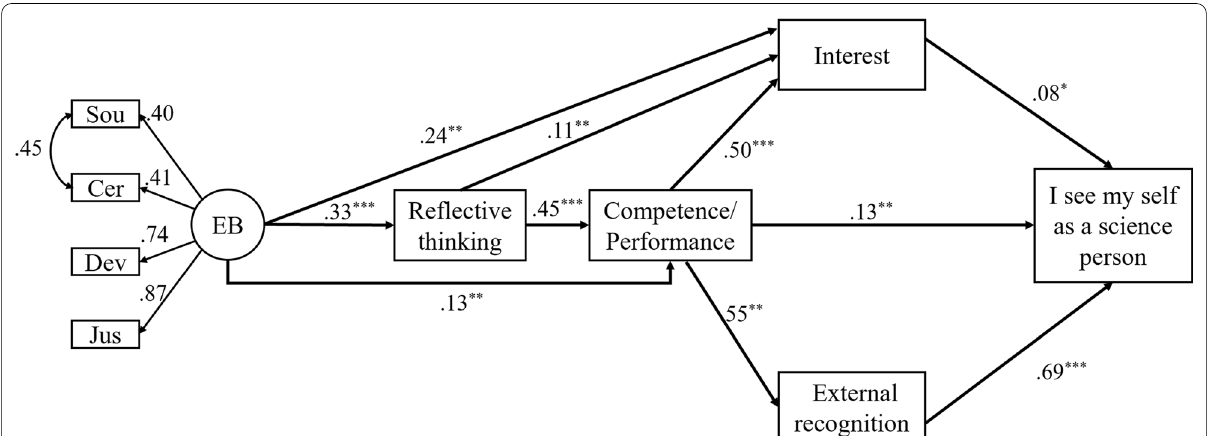
Fig. 4 Direct effects of epistemological beliefs, reflective thinking, competence/performance, interest, external recognition, and holistic impression on science identity. Note: *** p < .001; ** p < .01; * p < .05